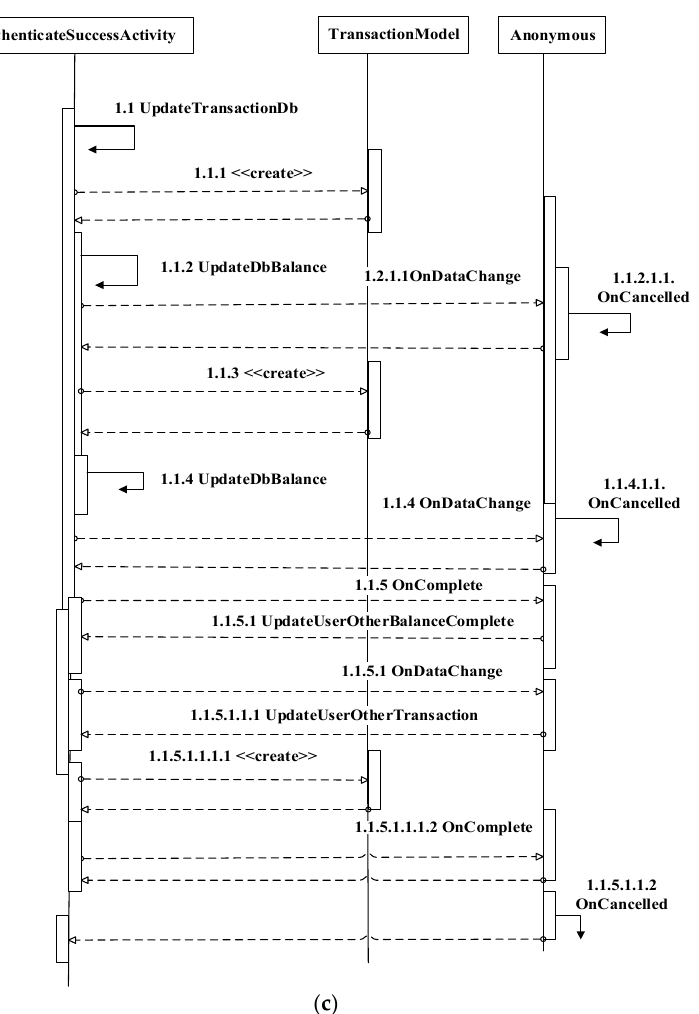
Figure 8. ( a ): Authentication activity of proposed method, ( b ): Authentication OTP activity of pro- posed method, and ( c ): Authentication successful activity of proposed method. In ( a ), Step 1.1: The AuthenticateActivity will hide the keyboard in the CommonUtil and return to the AuthenticateActivity